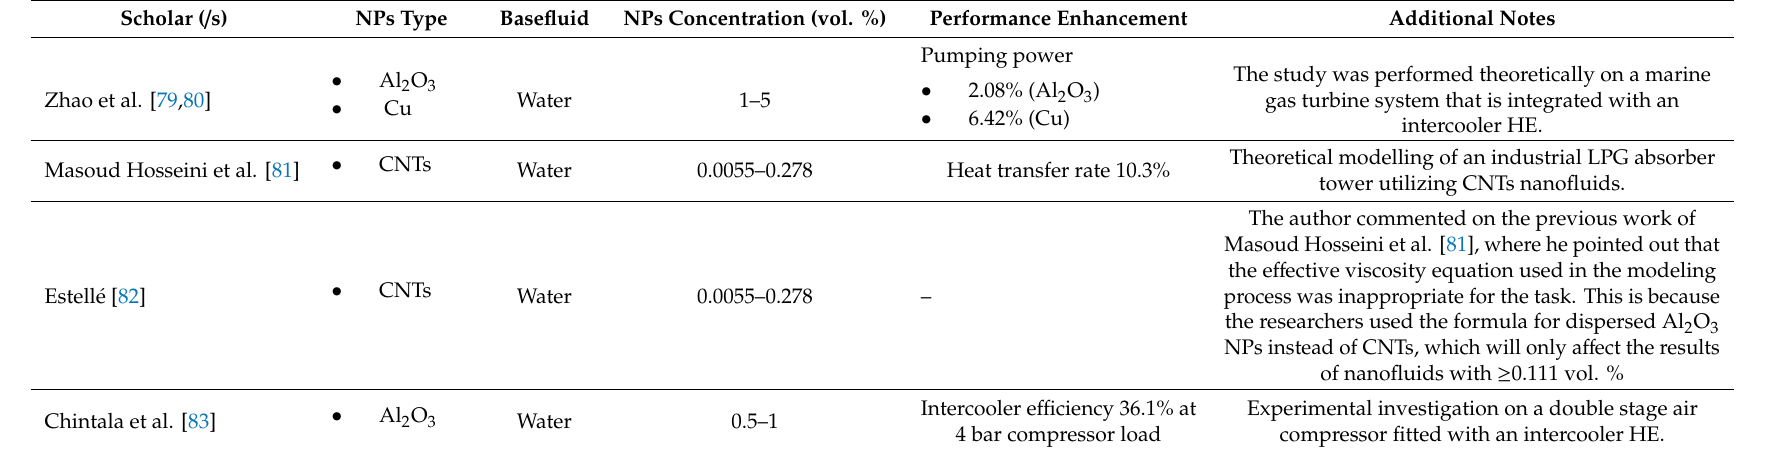
Table 4. Summary of the published work that was covered in Section